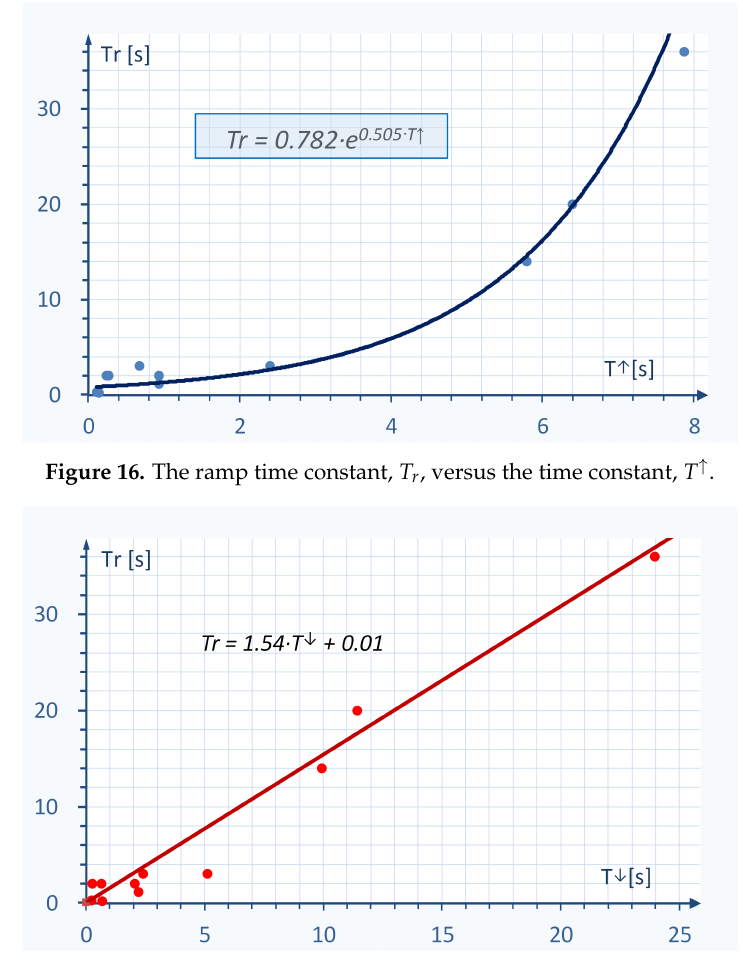
Figure 17. The ramp time constant, T r , versus the time constant, T ↓